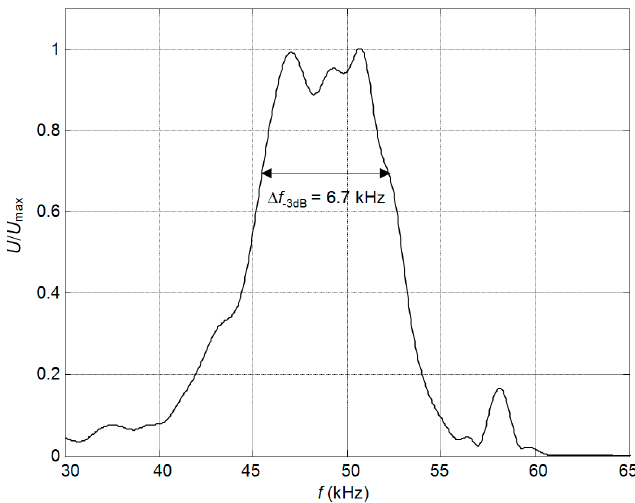
Figure 14. Experimentally determined normalized frequency response of the PMN-32%PT strip-like receiver with two non-rectangular electrodes (gap between electrodes at 45 ◦ angle, case B 2 ).